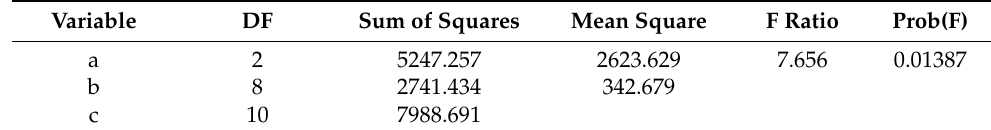
Table 11. The variance analysis.